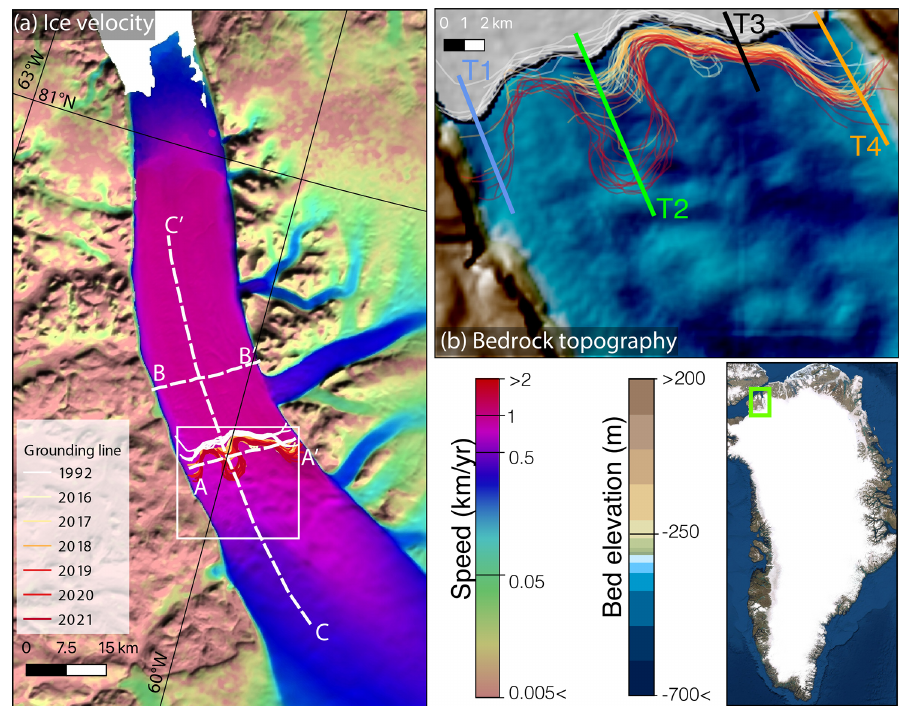
Figure 1. (a) Satellite-derived surface flow velocity of Petermann Glacier’s ice shelf color coded on a logarithmic scale from brown to red. Dashed white line indicates the location of velocity profiles (see Fig. 3). Inset map shows the location of Petermann ice shelf over the ice velocity map of the Greenland Ice Sheet (Mouginot et al., 2019). (b) Bedrock geometry from BedMachine v3 on a blue color scale (Morlighem et al., 2017). Lines T1, T2, T3, and T4 are used in Fig. 3a to show the evolution of the grounding line position over time. Solid color lines in panels (a) and (b) indicate the position of the QDInSAR grounding lines between 1992 and the present and are color coded on a scale from white (1992) to red